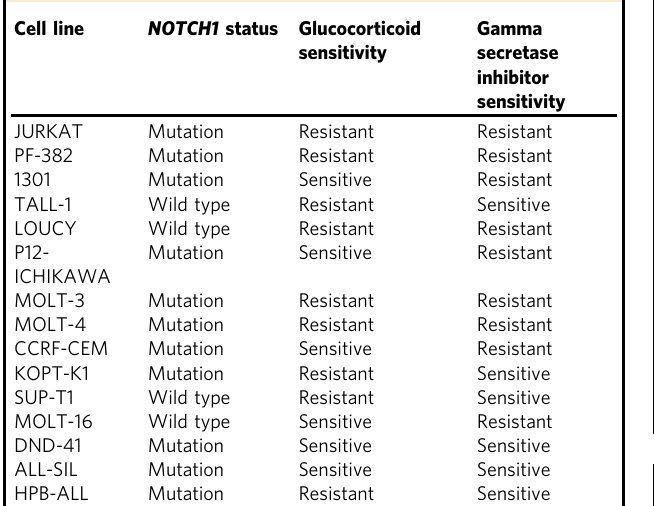
Table 3 PDX samples used in the in vitro and in vivo